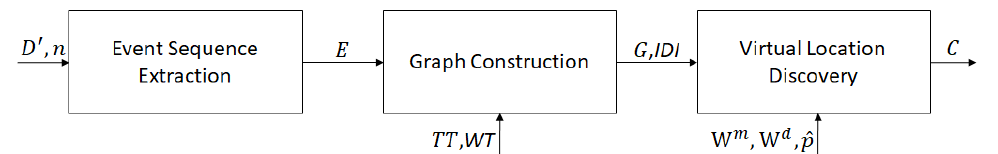
Figure 2. The procedure of virtual location discovery.